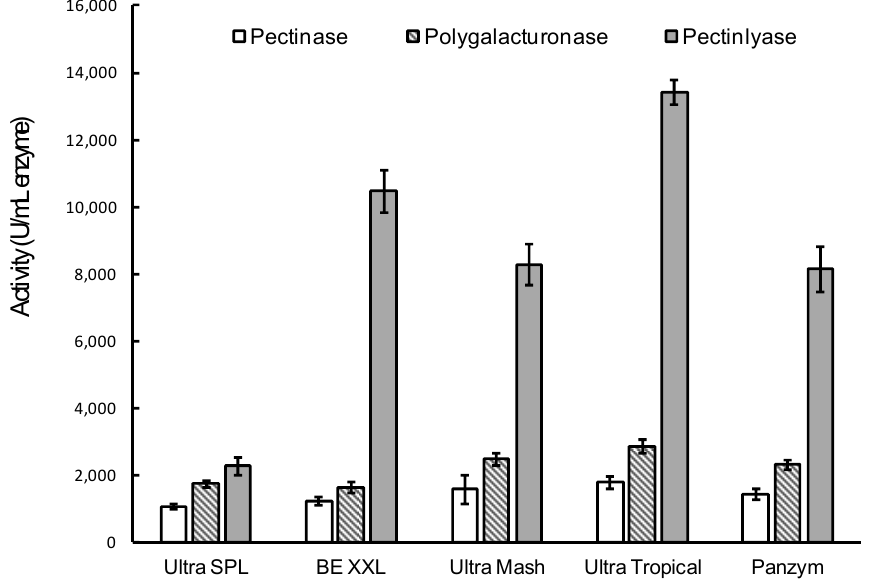
Figure 2. Pectinase, polygalacturonase, and pectin lyase activities of commercial pectinolytic enzyme preparations. All values are expressed as means ± standard deviation (n = 3).